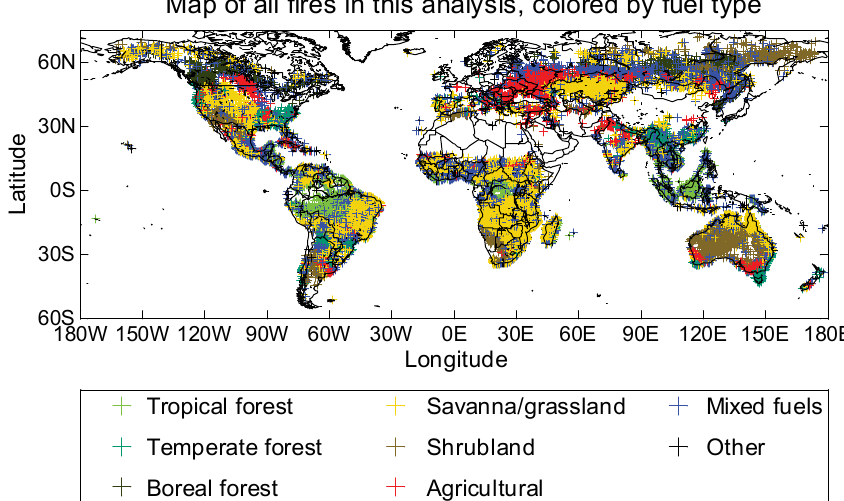
Fig. 1. Map of fires used in this analysis. Color indicates fuel type as determined using land cover and climatology. Fires were identified as having a particular fuel if greater than 75% of measured FRP for that fire came from fire pixels of a single fuel type; fires not meeting this criterion are designated “mixed fuels”. Fires are labeled as “other” if at least 75% of measured FRP came from fire pixels not assigned a biome